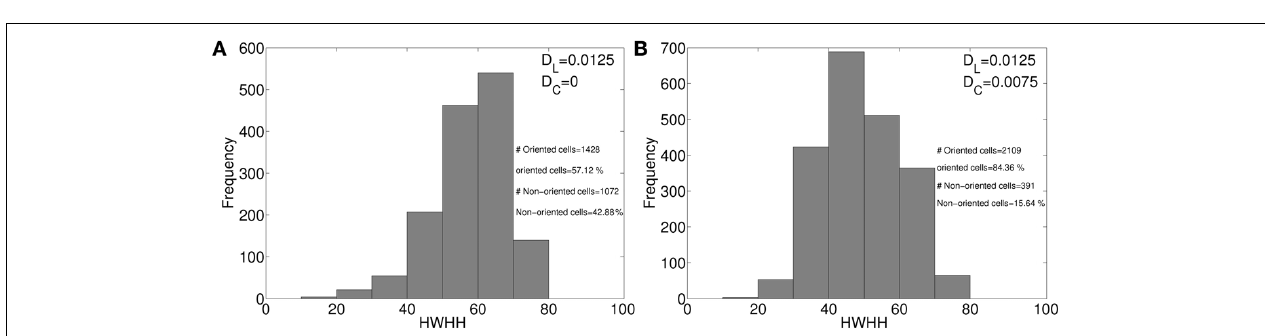
and those shown on the right are for the right eye. (B) The change in overall matching index for three different values of C-iter—500, 1500, and 2500 epochs, respectively.